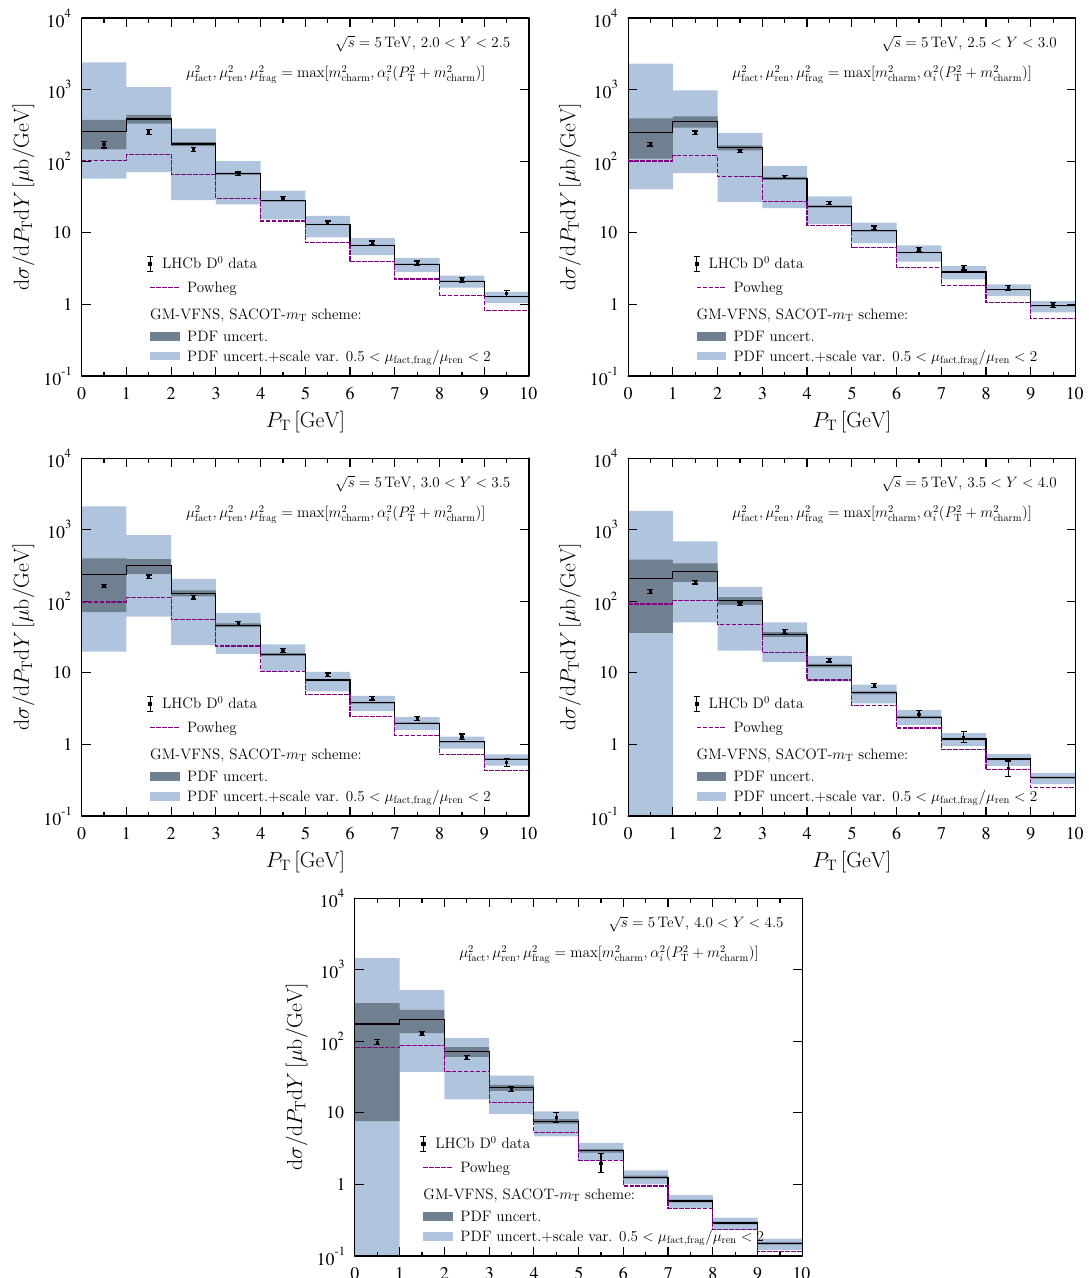
p Figure 9 . A comparison of the LHCb s = 5 TeV D 0 + D 0 data [3] with the GM-VFNS and Powheg calculations. The black lines indicate the central GM-VFNS results, the PDF uncertainty is shown as darker band, and the light-blue band is the PDF uncertainty and scale variation added in quadrature. The purple dashed line is the central result from Powheg